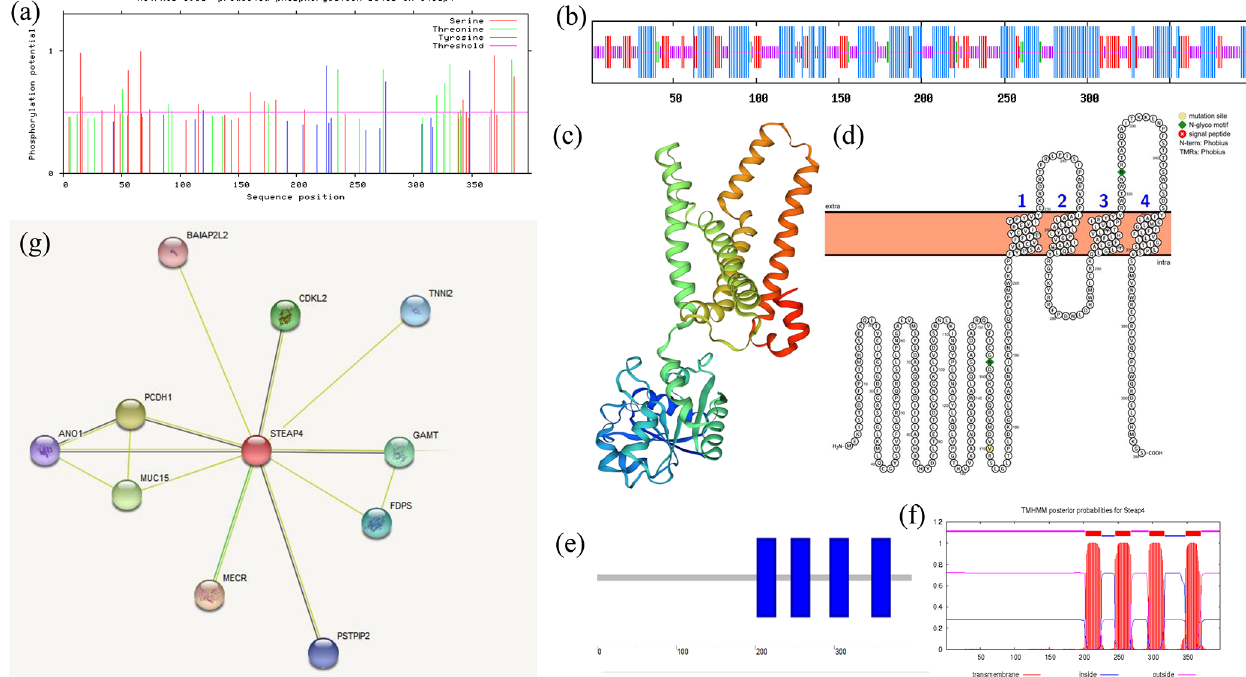
Figure 2. Analysis of goat STEAP4 protein characteristics. (a) STEAP4 protein phosphorylation site prediction. (b) Secondary-structure prediction. (c) Tertiary-structure prediction. (d, e, f) STEAP4 protein transmembrane structure prediction. (g) Interaction protein prediction of goat STEAP4 .